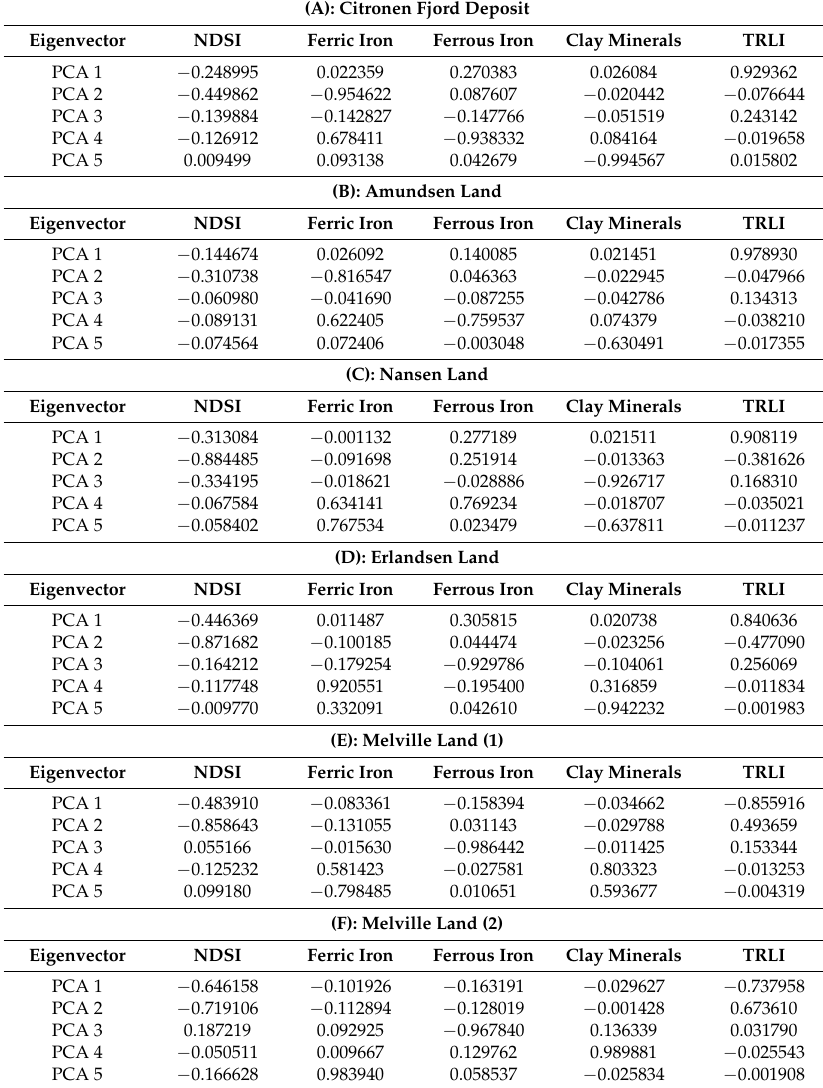
Table 3. Eigenvector matrix of the band ratio indices derived from the principal component analysis to Landsat-8 datasets, selected spatial subset scene covering (A) Citronen Fjord deposit, Peary Land, (B) Amundsen Land, (C) Nansen Land, (D) Erlandsen Land, SW Peary Land, (E) Melville Land (1), SE Peary Land, and (F) Melville Land (2), SE Peary